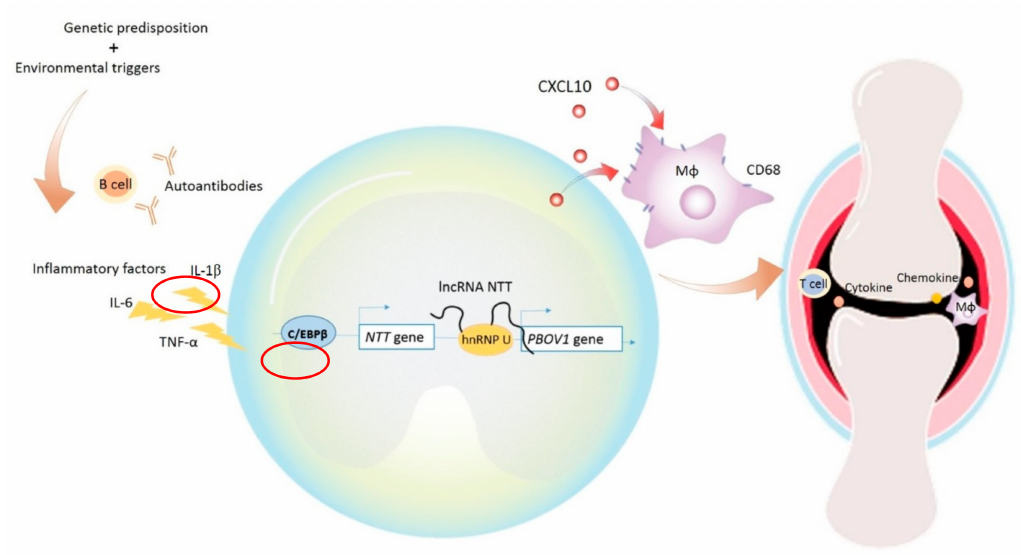
Figure 7. Graphical summary showing the proposed model of the roles of C/EBP β /NTT/PBOV1 upregulation in early RA pathogenesis. RA pathology could be induced by environmental triggers in genetically predisposed individuals. Autoantibodies produced by B cells and inflammatory cytokines such as IL-6, IL-1 β , and TNF- α appear in the disease process. Perhaps under the stimulation of these factors, the transcription factor C/EBP β binds to the promoter of NTT , leading to the transcription of NTT . NTT binds to the promoter of PBOV1 via hnRNP-U, then the enhanced expression of PBOV1 promotes monocyte/macrophage differentiation and the secretion of cytokines and chemokines including CXCL10. CXCL10 can promote the migration of immune cells to the site of inflammation, such as the synovial joints in